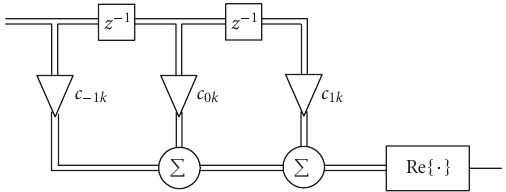
Figure 4: An example structure of the CFIR-SCE subcarrier equal-